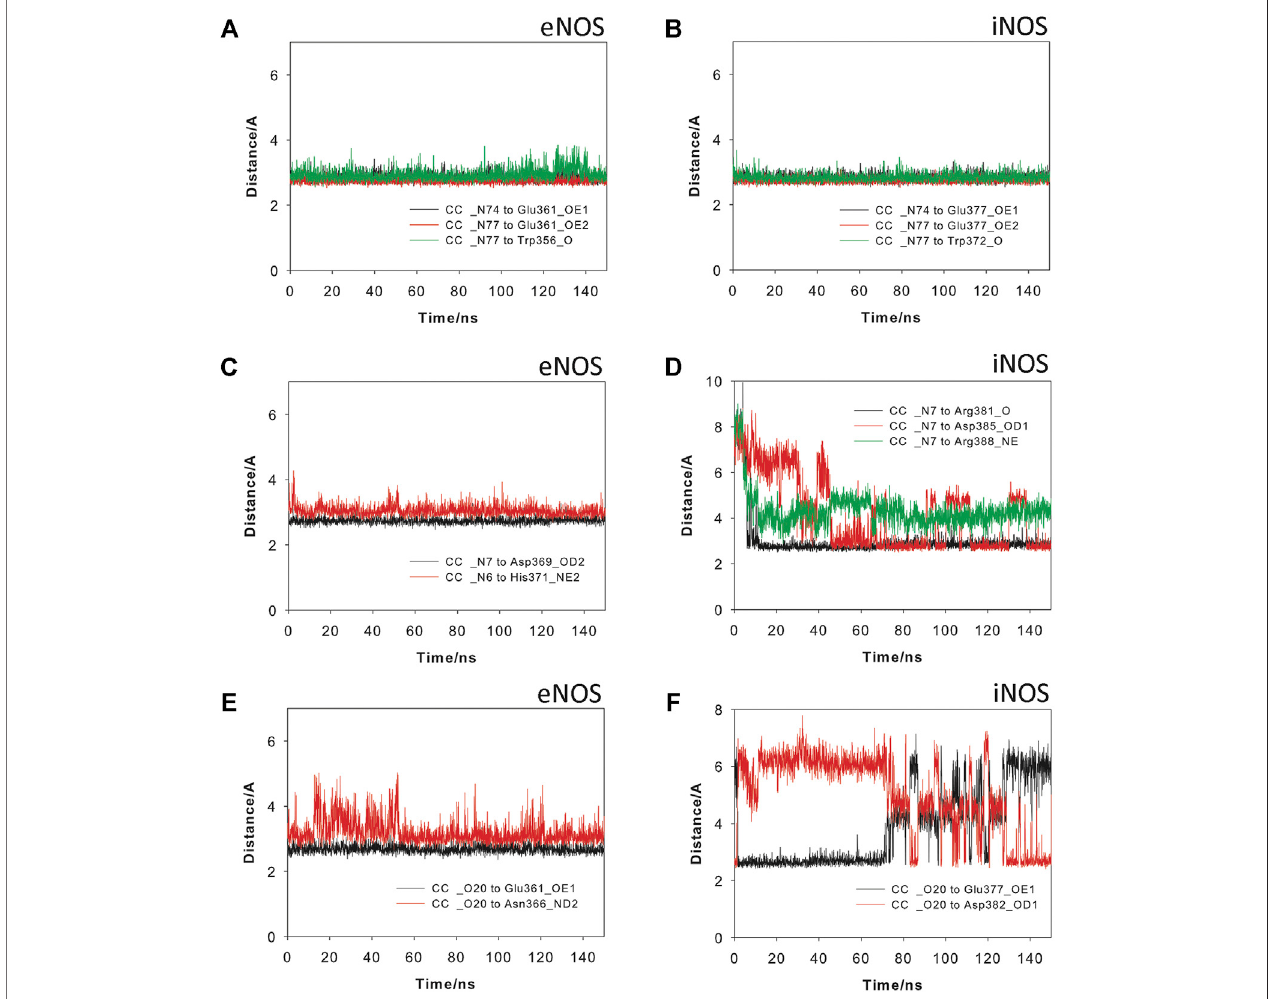
FIGURE 7 | Variation of the most relevant electrostatic and hydrogen bonding interactions of Crambrescin C1 (CC) when binding to the eNOS (A,C,E) and iNOS (B,D,F) enzymes during the simulation (150 ns). Interactions involving the guanidinium (A,B) and pyrimidinium (C,D) moieties, and the hydroxylated side chain (E,F) are shown.